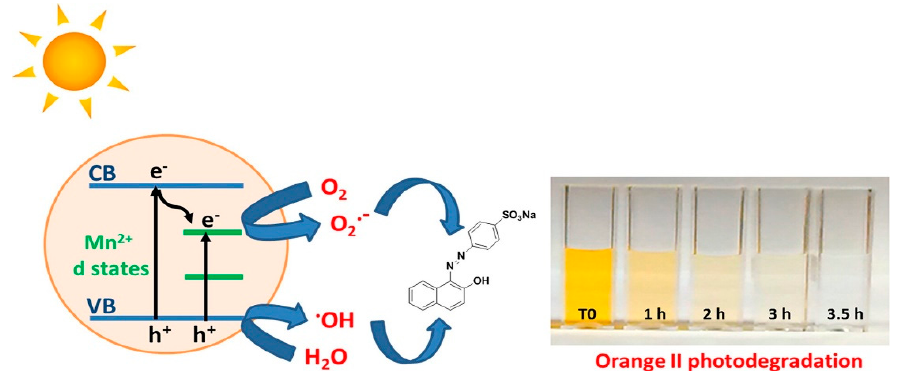
Figure 4. Formation of superoxide anion and hydroxyl radicals on Mn-doped ZnO nanoparticles for degrading Orange II dye under solar light irradiation at different intervals of time. Reproduced from [109] with permission of Elsevier.